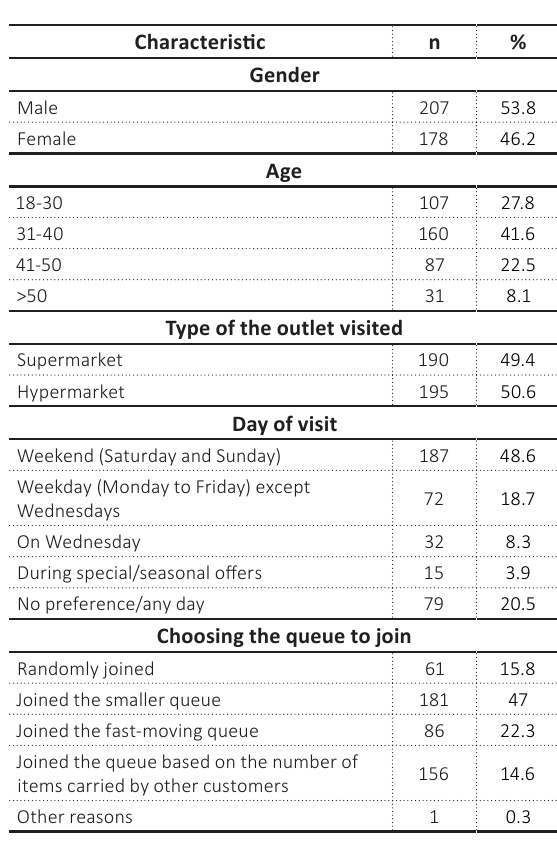
Table 1. Sample demographics and queuing